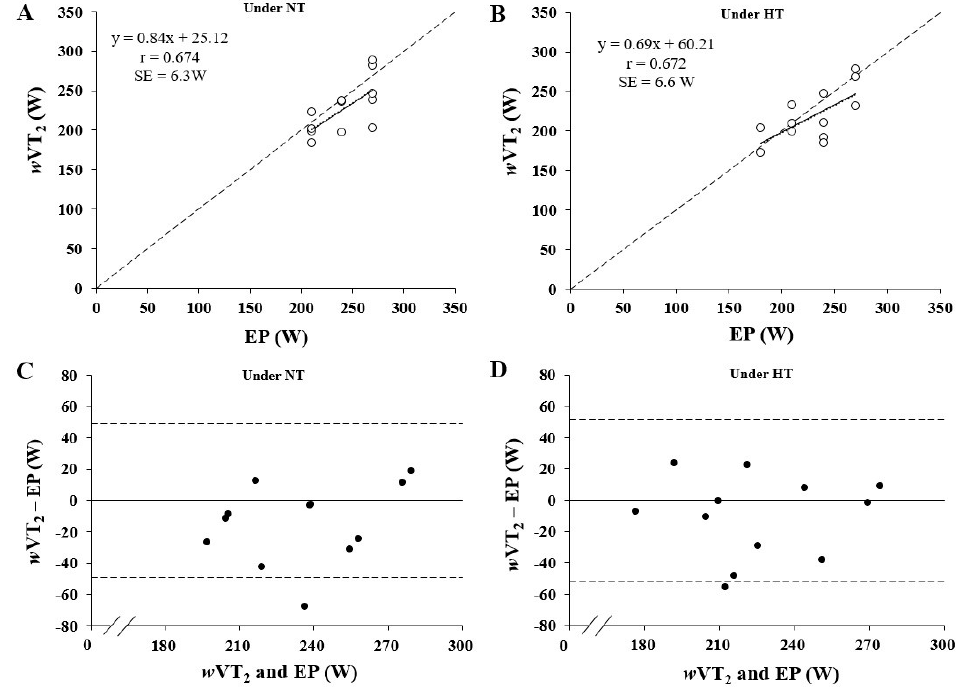
Figure 2. Correlation ( A , B ) and Bland–Altman plot ( C , D ) analyses for power differences between the second ventilatory threshold (VT 2 ) and the end power (EP) during 3-min all-out test under thermoneutral temperature (NT) and high temperature (HT). In panels ( A , B ), the solid line is the best-fit linear regression and the dashed line is the line of identity. In panels ( C , D ), the solid line represents the mean difference between the two trials, and the dashed line represents the 95% limits of agreement. Table 1 indicates that the VO 2max of the IETs under HT was significantly higher than under NT. In terms of power output, w VO 2max , w VT 1 , and w VT 2 under HT were significantly shorter than under NT ( p <